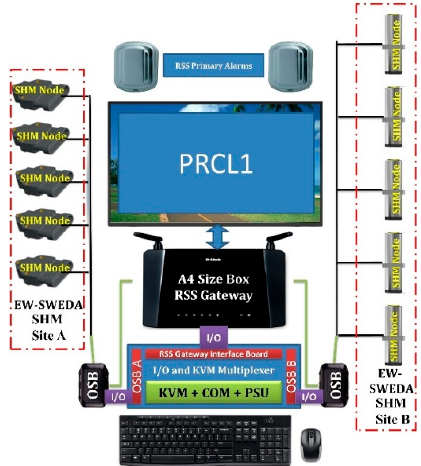
Figure 14. Realization of a regional SWEDA-SDM hardware prototype.